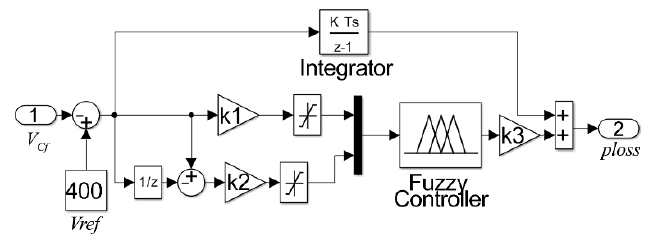
Figure 7. Fuzzy controller for the voltage control loop.